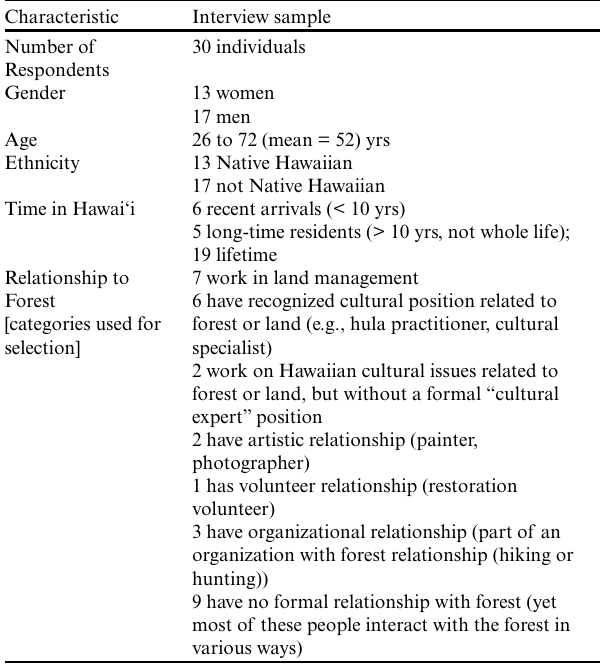
Table 1 . Characteristics of